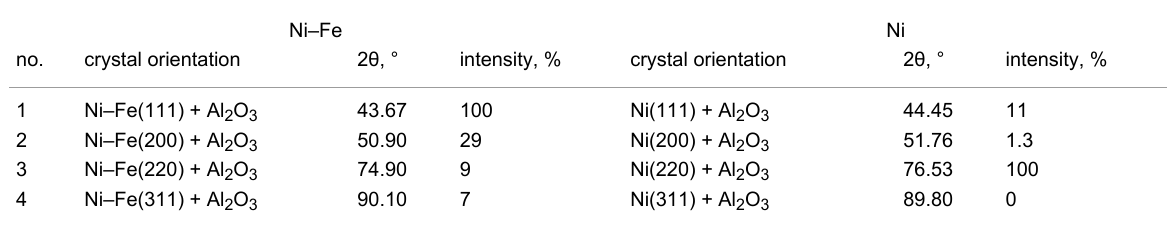
Table 3: The main characteristics of XRD patterns for Ni and Ni-Fe in Al 2 O 3 . Ni–Fe Ni no.